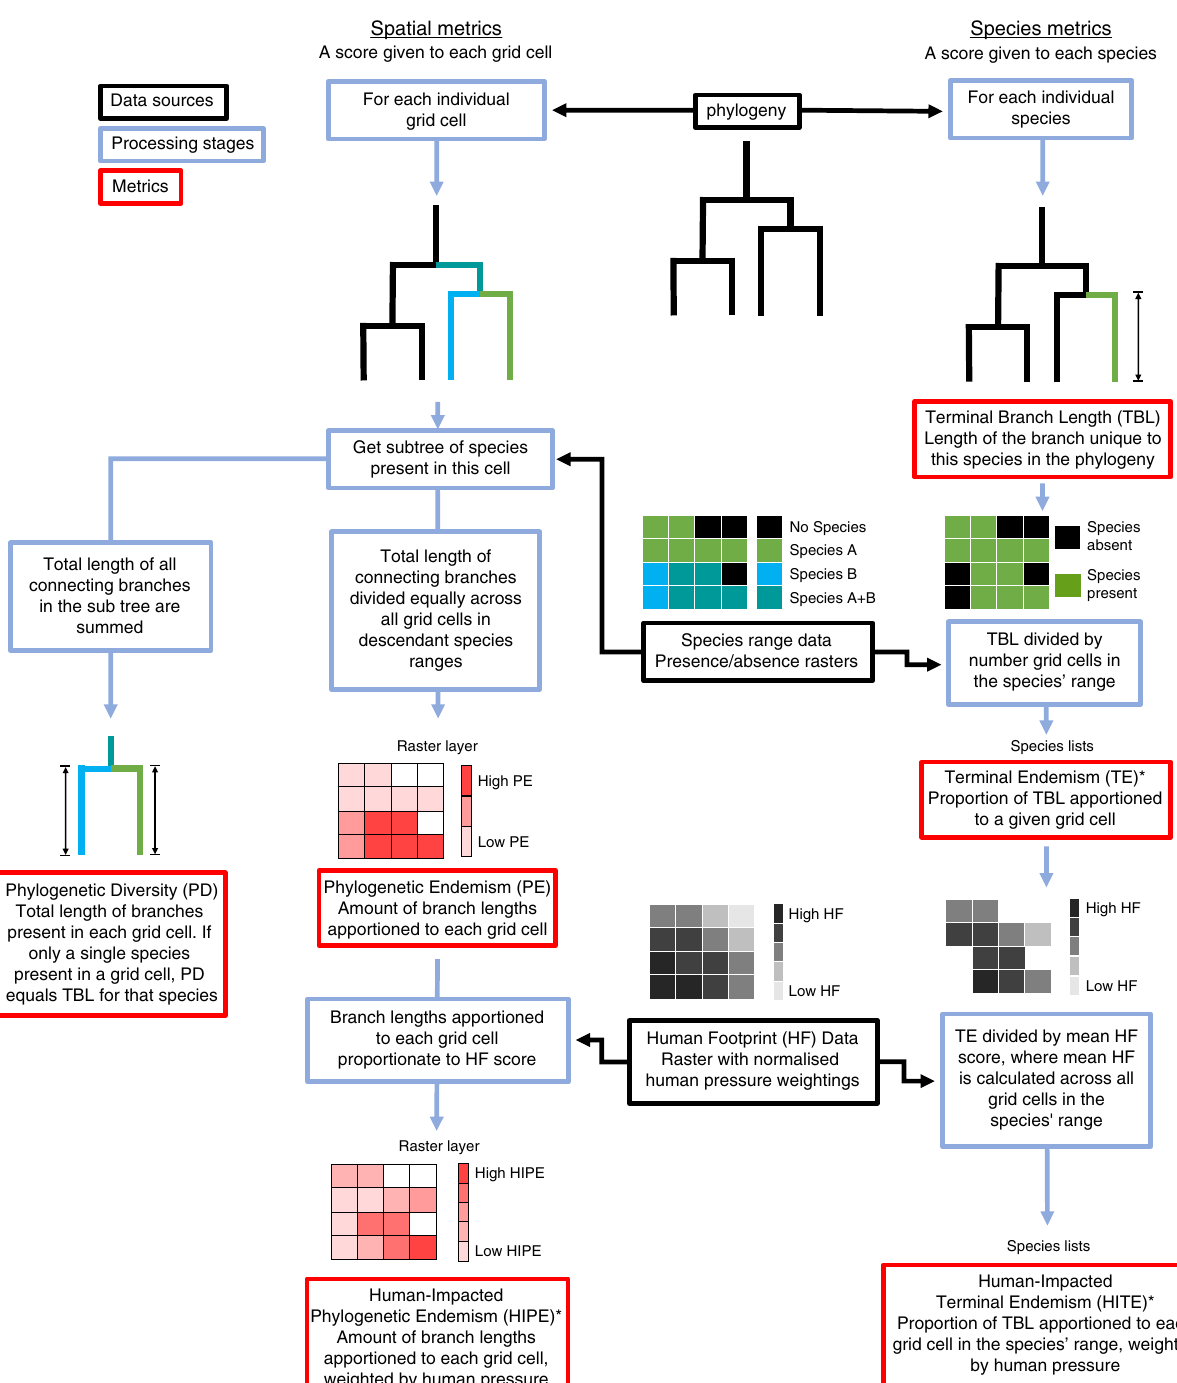
Fig. 1 Relationships between spatial and species-level phylogenetic diversity-based metrics. Flowchart illustrating the data sources used, stages of processing, and relationships between the spatial and species-level metrics used here. Metrics are in red boxes, data sources in black, and processing stages in blue. Only those metrics for which results are reported and presented in the main text are included. Our three novel metrics are denoted with asterisks. Mathematical de fi nitions for all spatial and species-level metrics are discussed in Supplementary Table